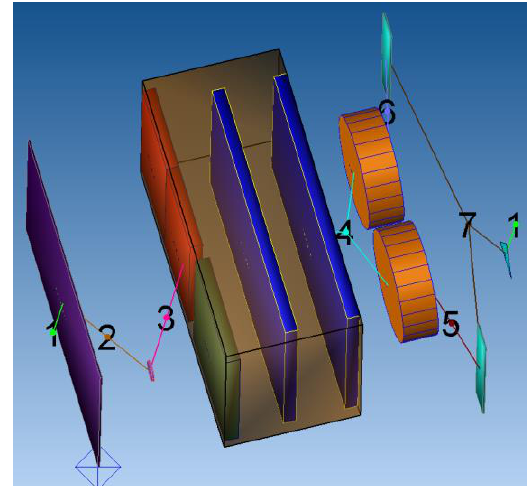
Fig. 2. 3D model of the cooling system (violet – inlet grit, green – charge air cooler, red – oil cooler, blue – radiator, orange – fan, light green – outlet